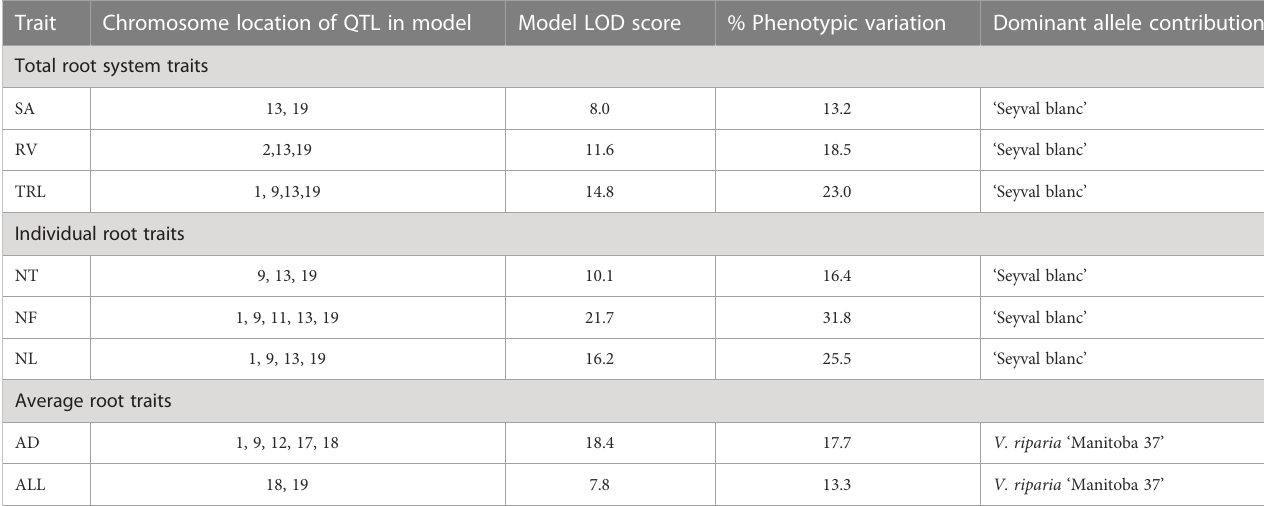
TABLE 5 RSA trait model phenotypic variation and genotype dominant allele contribution. Trait Chromosome location of QTL in model